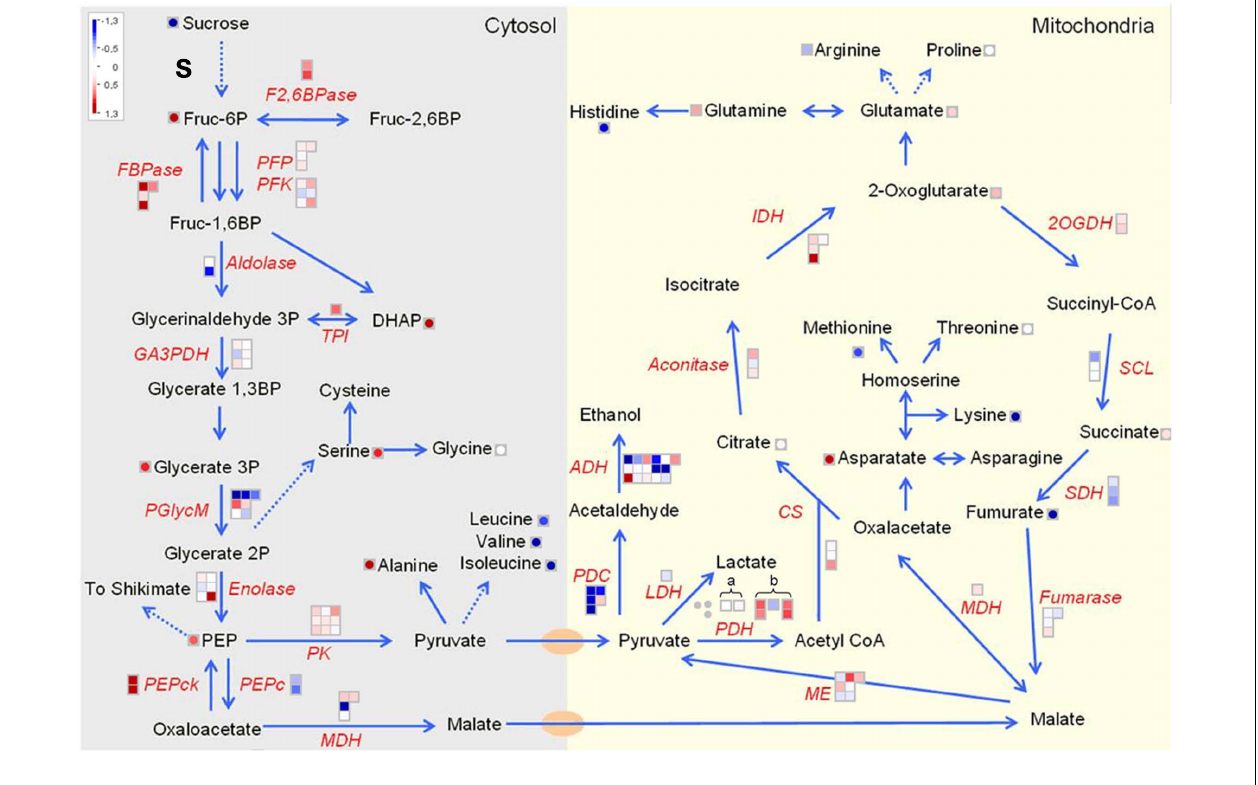
FIGURE 11 |Tricarboxylic acid cycle and respiration in U-IN-2. The E2 (a) and E3 (b) subunits of the mitochondrial pyruvate dehydrogenase